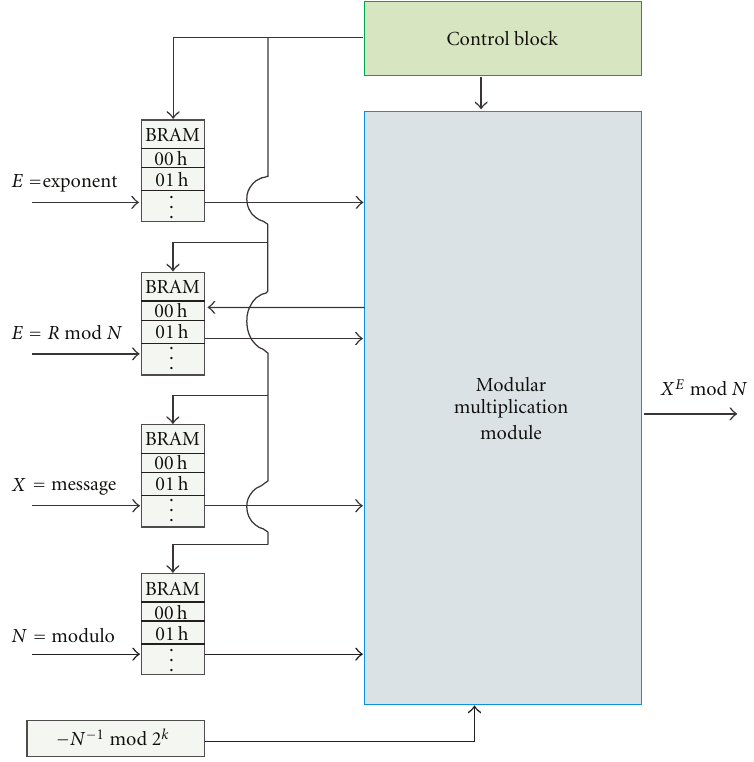
Figure 11: Modular exponentiation architecture.